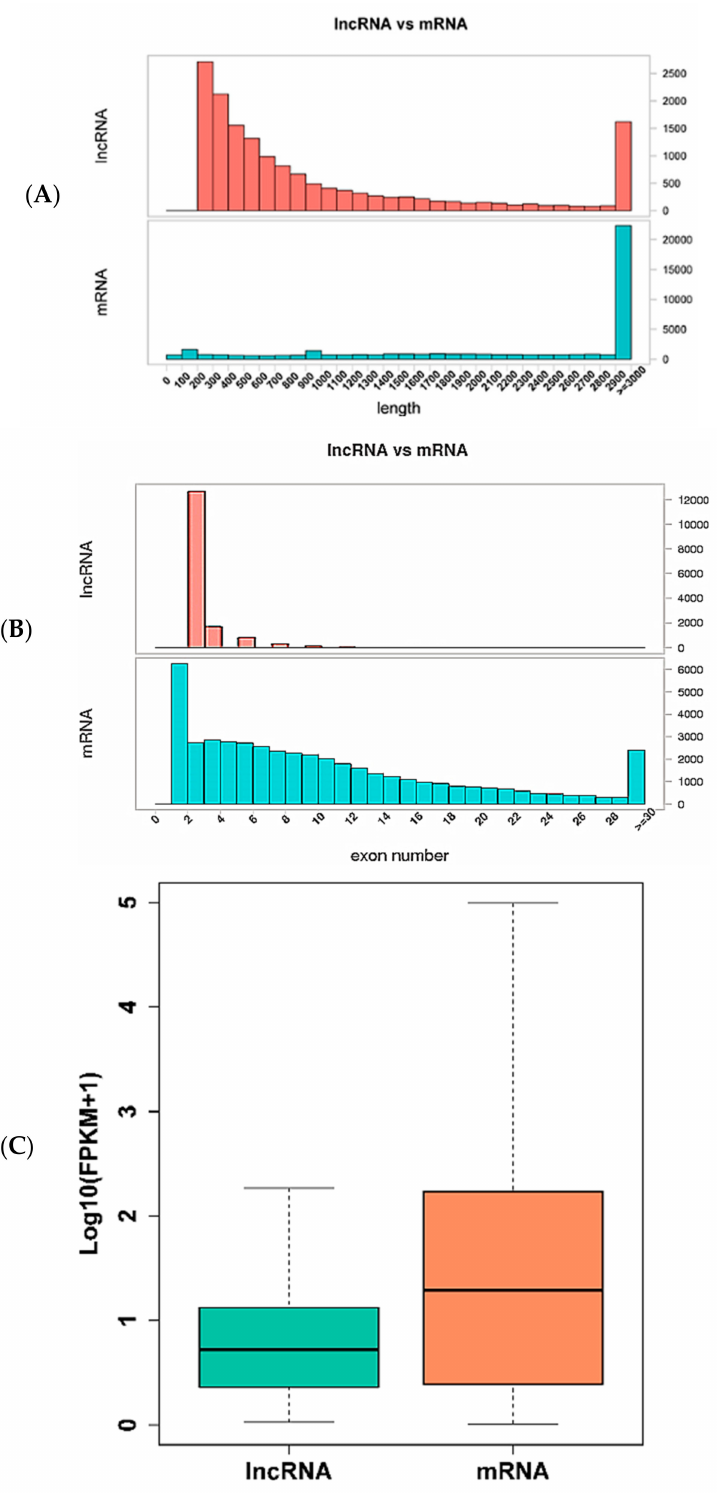
Figure 3. Comparison of genomic architecture and expression level of lncRNAs and messenger RNAs (mRNAs). ( A ) Distribution of lengths of lncRNAs and mRNAs. ( B ) Distribution of number of exons of lncRNAs and mRNAs. ( C ) Expression level of lncRNAs and mRNAs, calculated as log 10 (FPKM + 1). FRKM: Fragments Per Kilobase of exon per Million fragments